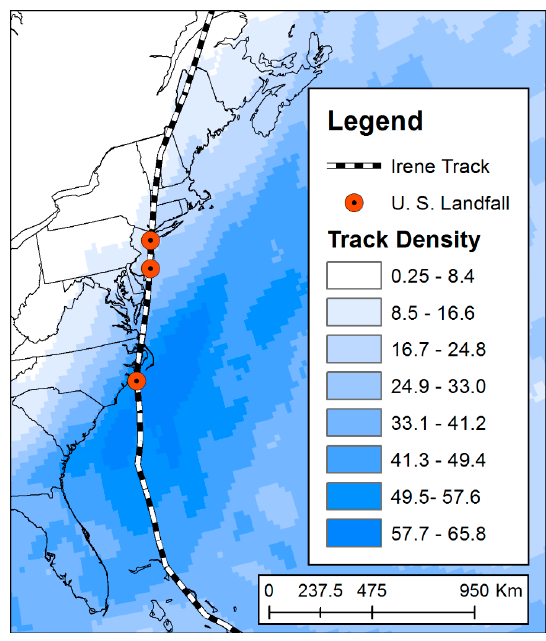
Figure 2. Track density map for all HURDAT2 track segments 1851–2016. Values correspond to the area occupied by track segment lengths (km) with a 1° search radius for each 25 km × 25 km grid cell. Units are kilometers by square kilometer.